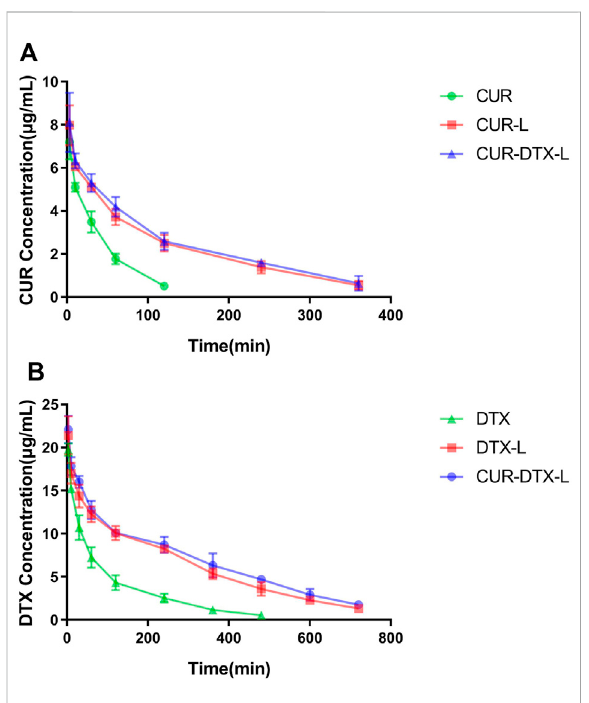
FIGURE 3 (A) Plasma concentrations vs. time curves of DTX in SD rats after intravenous injection of DTX, DTX-L, and CUR-DTX-L ( n = 6). (B) Plasma concentrations vs. time curves of CUR in SD rats after intravenousinjectionofCUR,CUR-L,andCUR-DTX-L( n =6).